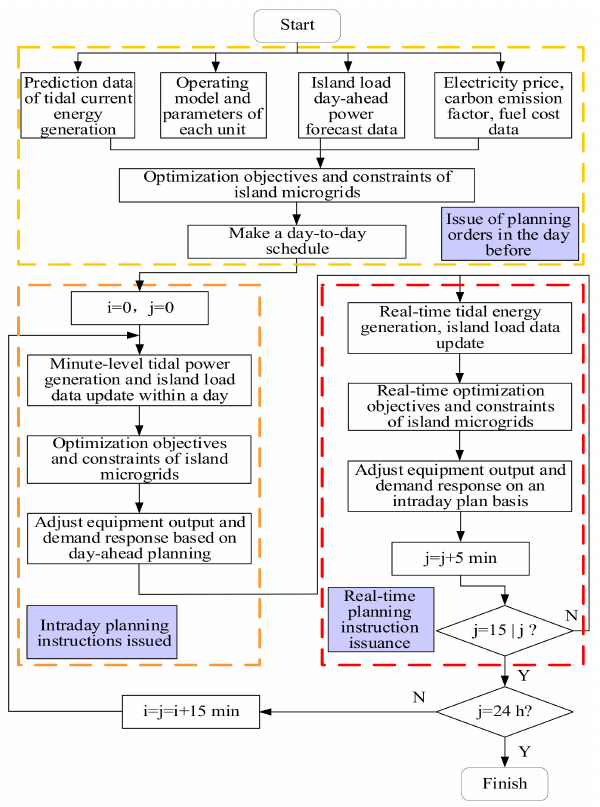
Figure 6. Implementation process of island microgrid multiple time scales rolling coordinative